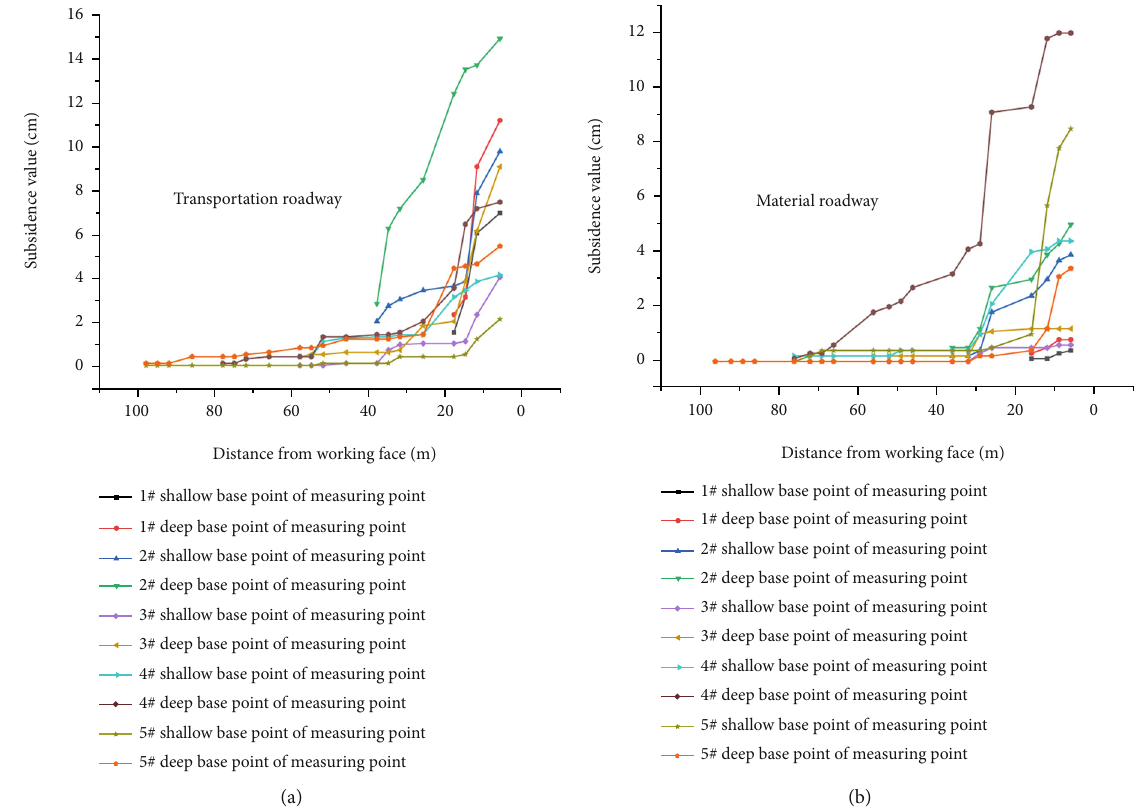
Figure 8: Relationship between the pressure value of dynameter and the distance from the working face.